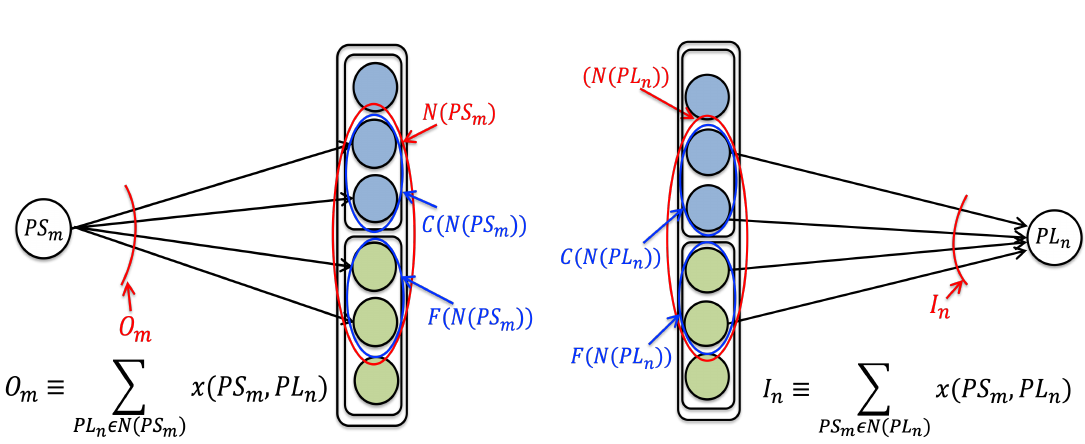
Figure 4. Connections between Power Sources and Power Loads. ( a ) A power source with connections; ( b ) A power load with